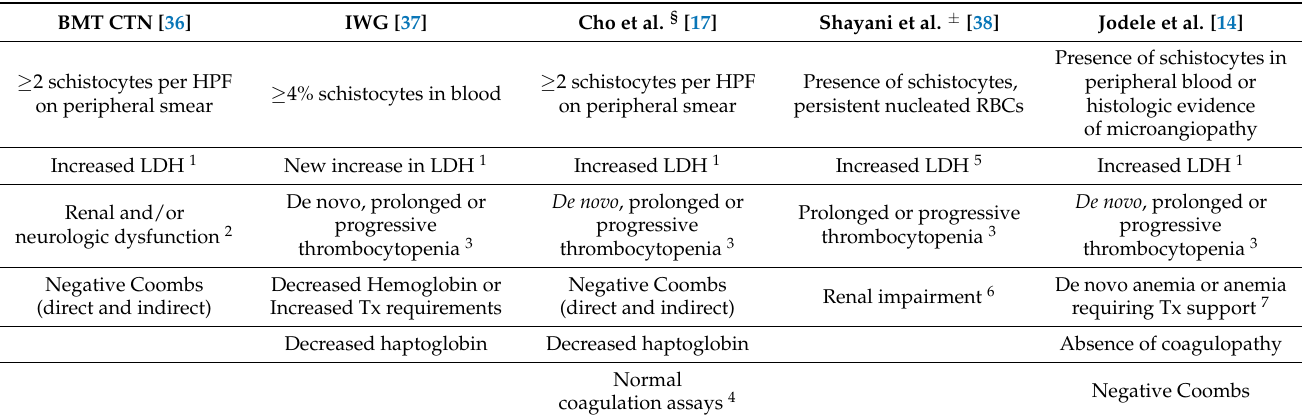
Table 1. Overview of different diagnostic criteria for